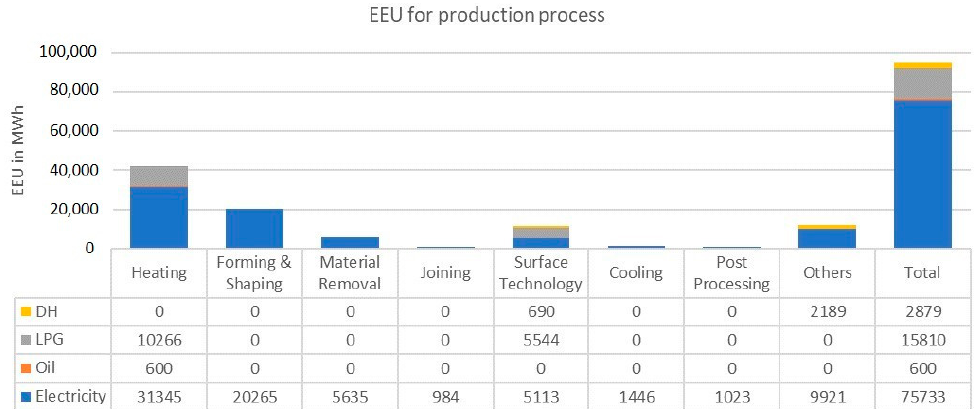
Figure A1. Energy use for the unit processes in the production category based on the case study of the Swedish engineering industry.